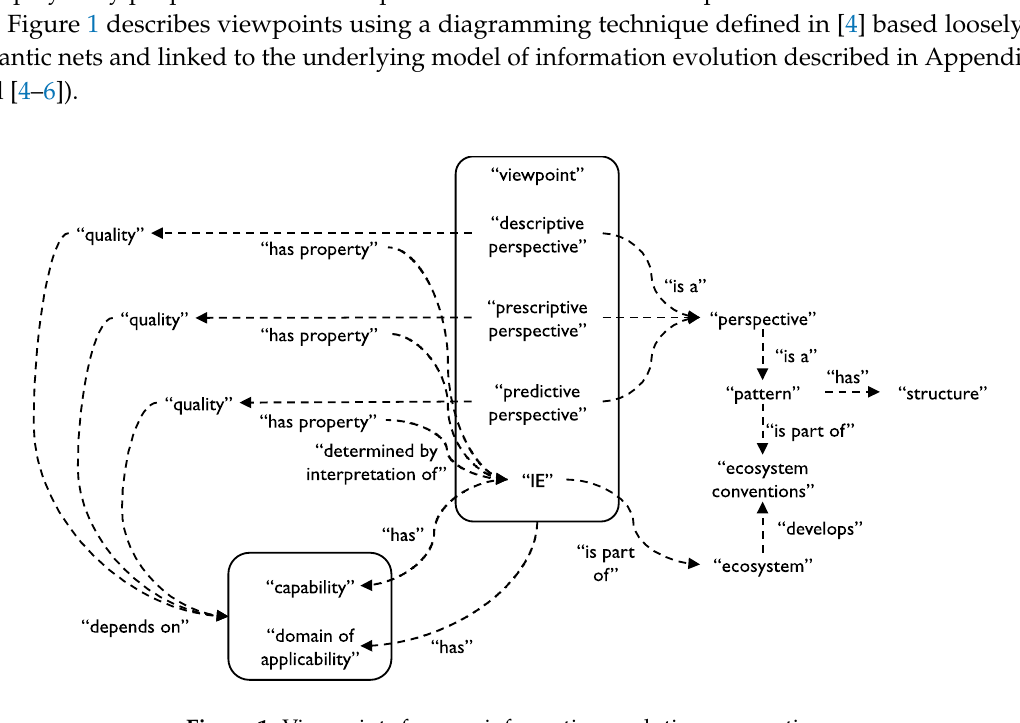
Figure 1. Viewpoints from an information evolution perspective.